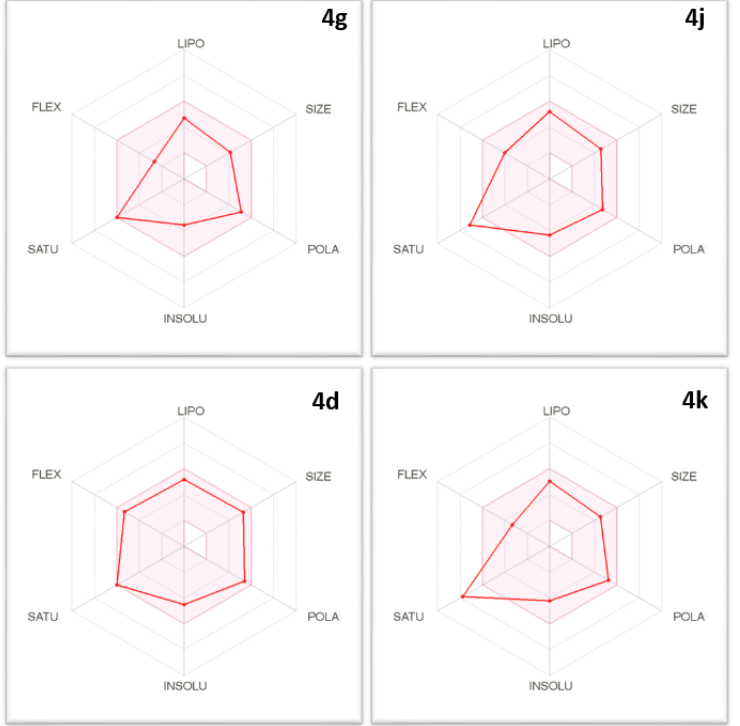
Figure 20. The bioavailability radar plots for the tested compounds (the colored zone is the suitable physicochemical space for oral bioavailability).